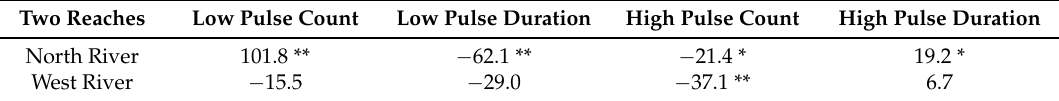
Table 5. The change of the frequency and duration of high and low pulses in the JRW (%).